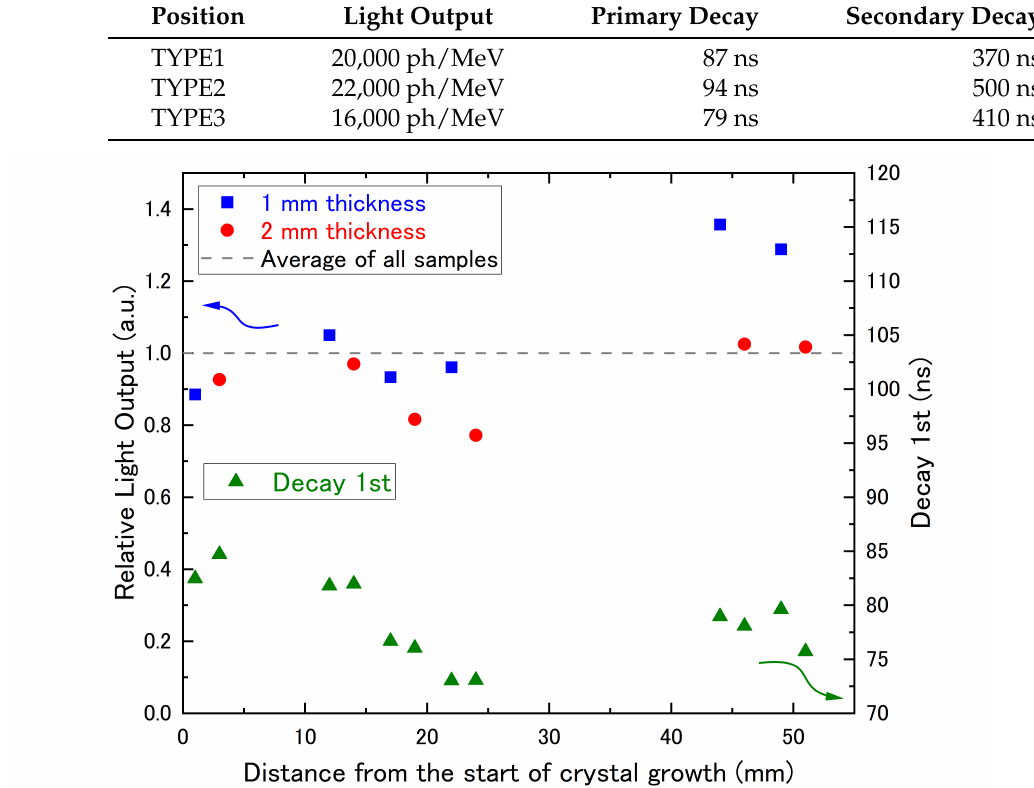
Figure 8. The scintillation properties of samples grown by TYPE3 crucible as a function of the distance from the growth start. A standard deviation ( σ ) of ± 16% was achieved in scintillation light output over a 50 mm crystal length.